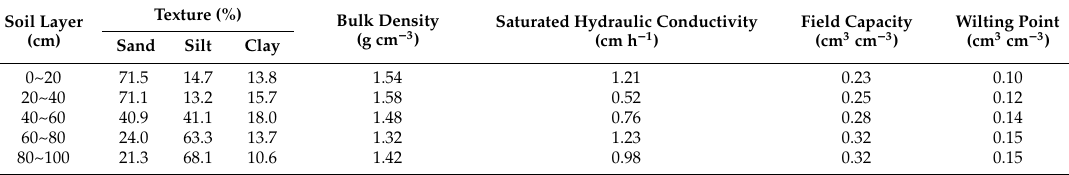
Table 1. Soil properties of the experimental field at the Shiyang River Basin Experiment Station. Soil Layer